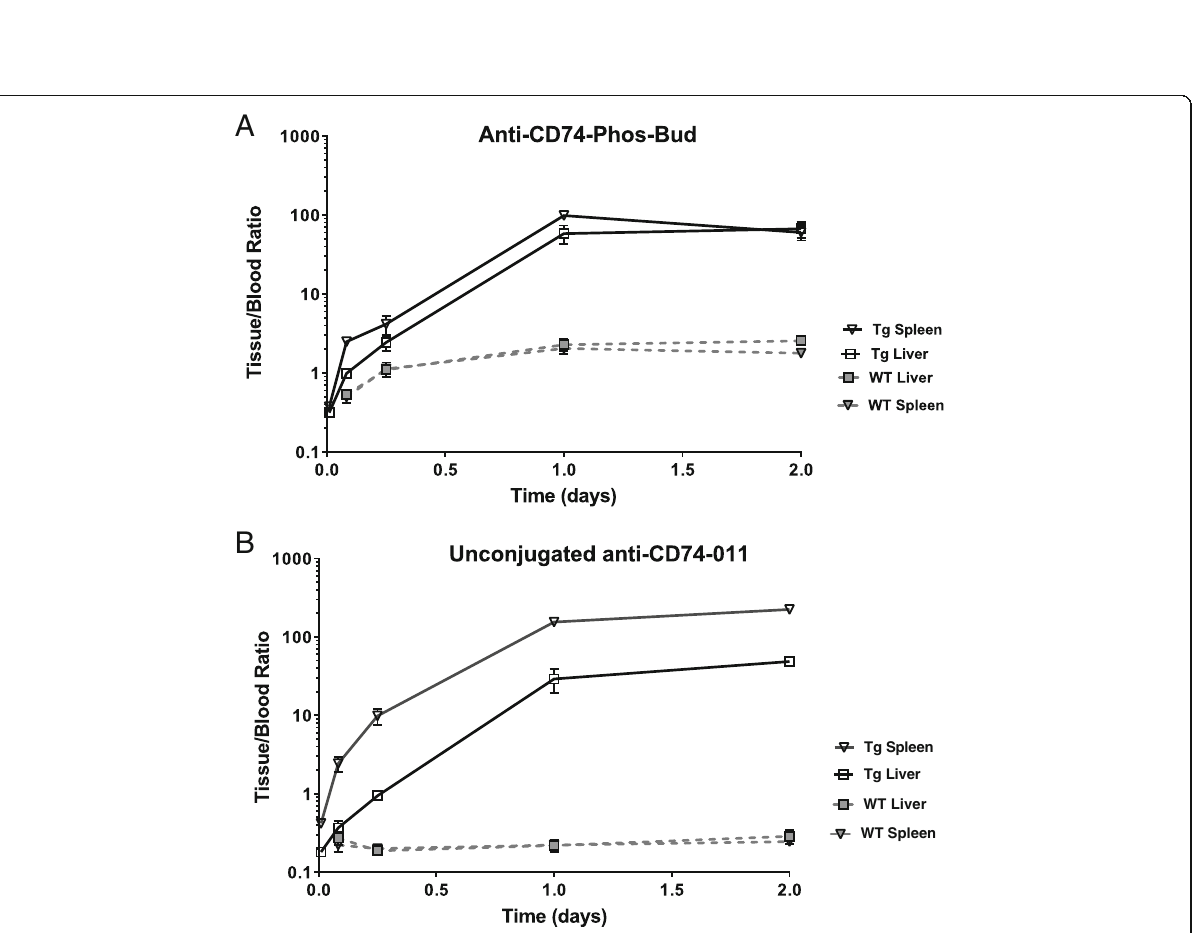
Fig. 7 Spleen and liver tissue to blood ratios of anti-CD74-Phos-Bud ( a ) and an unconjugated anti-CD74 – 011 ( b ) in wild type (WT) and human CD74 + transgenic (Tg) mice. Tissue/blood ratios were calculated from drug concentration measured by fluorescence emission-linked assay in blood and the tissues at 2 h, 6 h, 1 and 2 days after 5 mg/kg IV dosing. An additional 15 min time-point was collected for anti-CD74-Phos-Bud in Tg mice. Tissue/blood ratios greater than 1 are indicative of tissue uptake. Data plotted are mean from two mice per time point. Error bars correspond to the range. Error bars smaller than the symbol are not